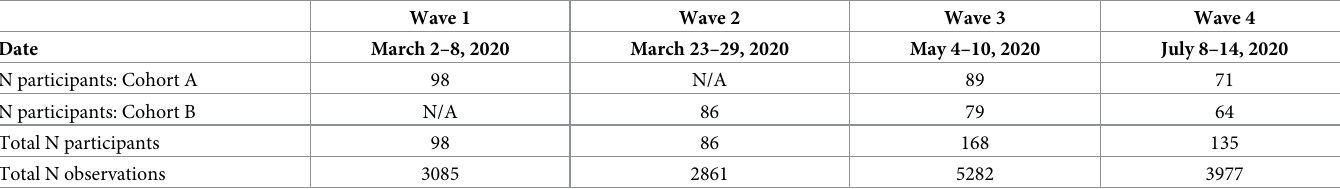
Table 1. Study design and sample size